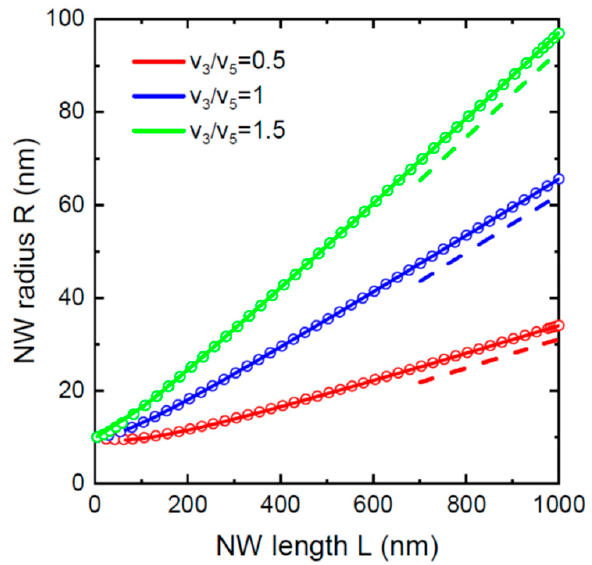
Figure 1. Evolution of the NW radius with length in the asymptotic growth stage, obtained from Equation (17) at a fixed L ∗ = 1000 nm (corresponding to different R ∗ ), v 3 / v 5 = 1, α 3 = α 5 = 30 ◦ , c = 1, and β = 130 ◦ , and three different pitches P shown in the legend.